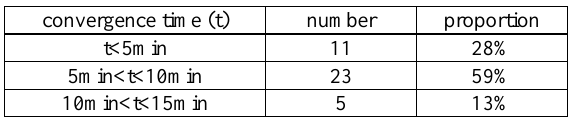
Table 5. convergence time analysis of 39 fixed solutions